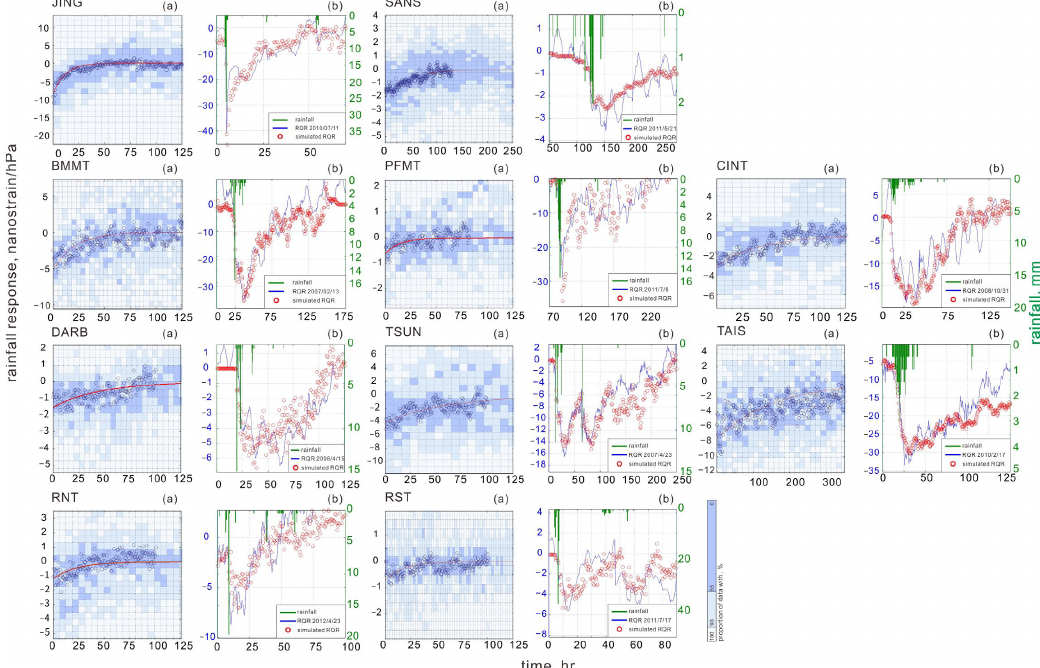
Figure 4. The left panel ( a ) shows the rainfall-induced strain changes, which represent the rainfall impact functions corresponding to the rainfall events. The blocks on the base map show the distribution of discrete data of rainfall quick responses (RQRs) in a certain timespan. The darker blue area means there are more than 65% discrete data within, adding lighter ones contain more than 90% of the data, the average functions (blue circles) and continuous fitting curves (red lines) are also shown. The right panel ( b ) displays the comparison between the simulated RQR (red circles) and observed RQR (blue lines) and rainfall data (green lines). The simulated data are obtained by multiplication of the average rainfall function with the rainfall.